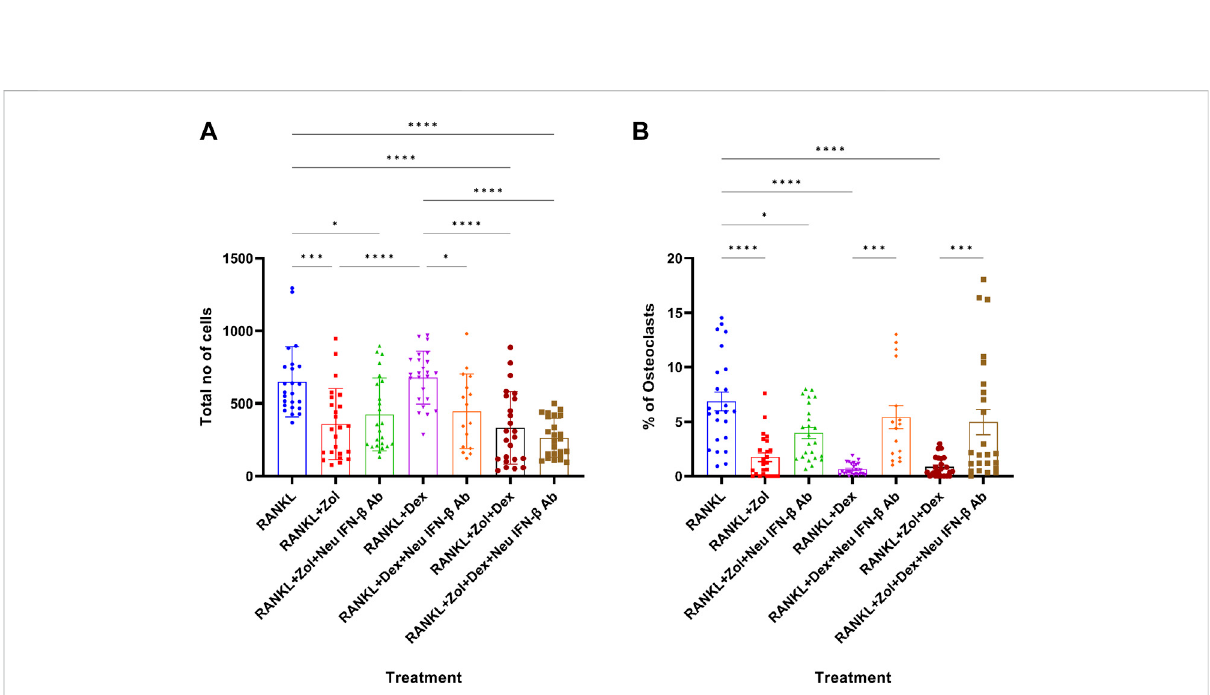
FIGURE 4 Drug-induced inhibition of osteoclastogenesis is mediated by IFN- β . Macrophages were treated for 48 h with RANKL and Zol, Dex or Zol+Dex, and anti-IFN- β neutralizing antibodies (2 μ g/ml). Then, culture media was replaced and resupplemented with RANKL for additional 3 days. Next, the cells were stained for TRAP and enumerated, and analysis was performed by the ImageJ software for total cell number (A) and % of osteoclasts (B) . Statistical signi fi cance by one-way ANOVA is indicted ( n = 3, 8 fi elds counted). * p < 0.05, ** p < 0.01, *** p < 0.001, **** p <